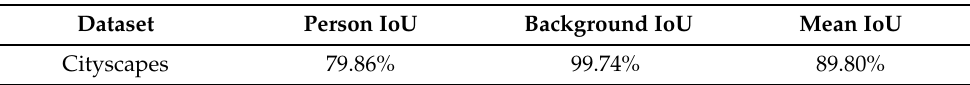
Table 1. Per-class IoU (%) results for different models on the Cityscapes Validation set. The column of Person Class is highlighted.